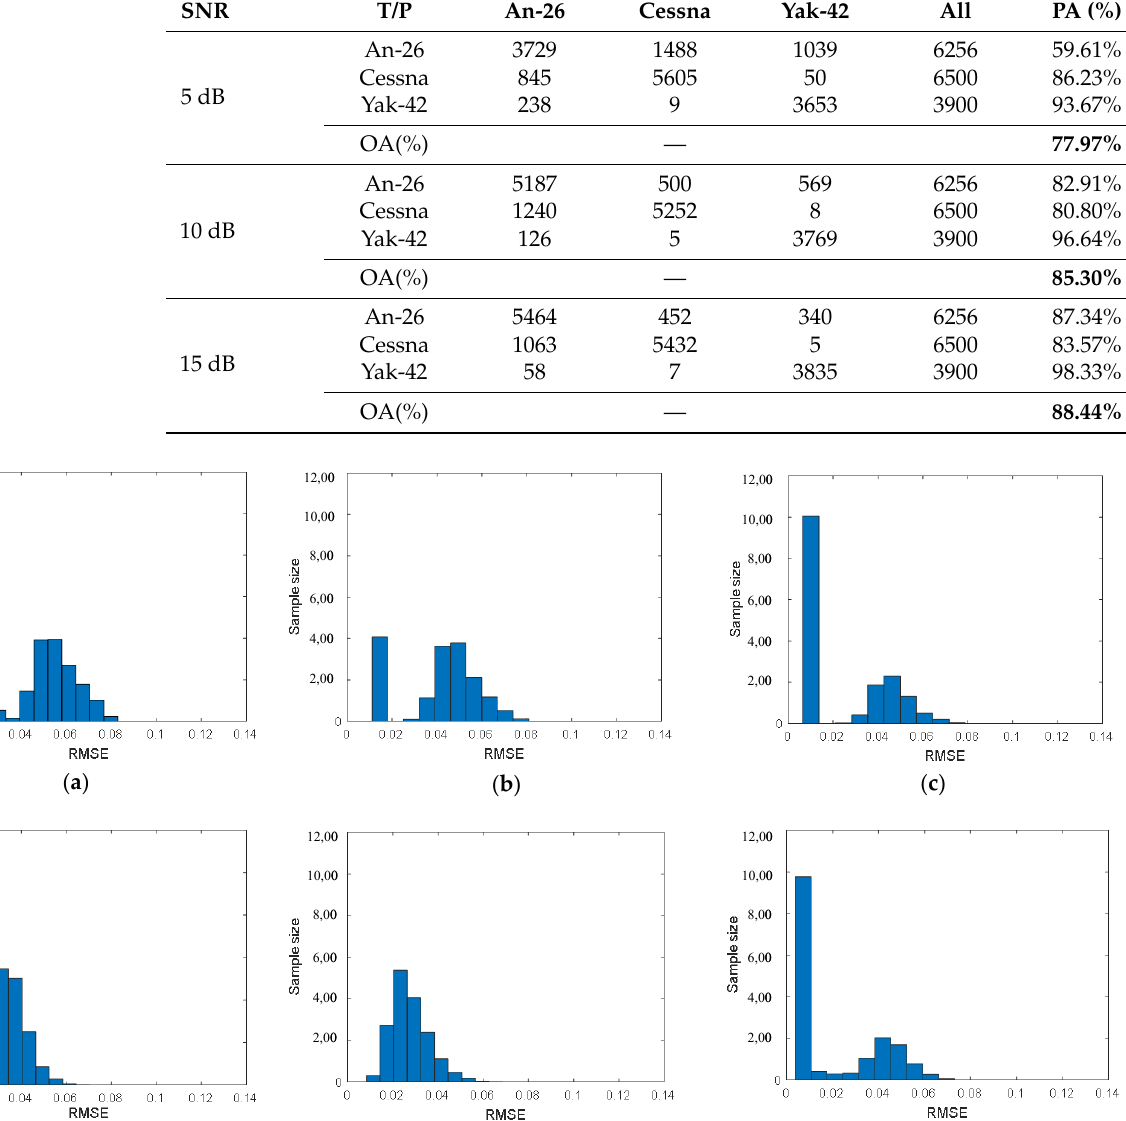
Table 5. Recognition results of the IDR-Net on test sets.